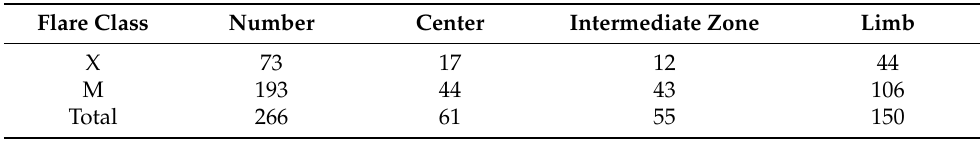
Table 2. Results of solar flare identified on the sun surface.